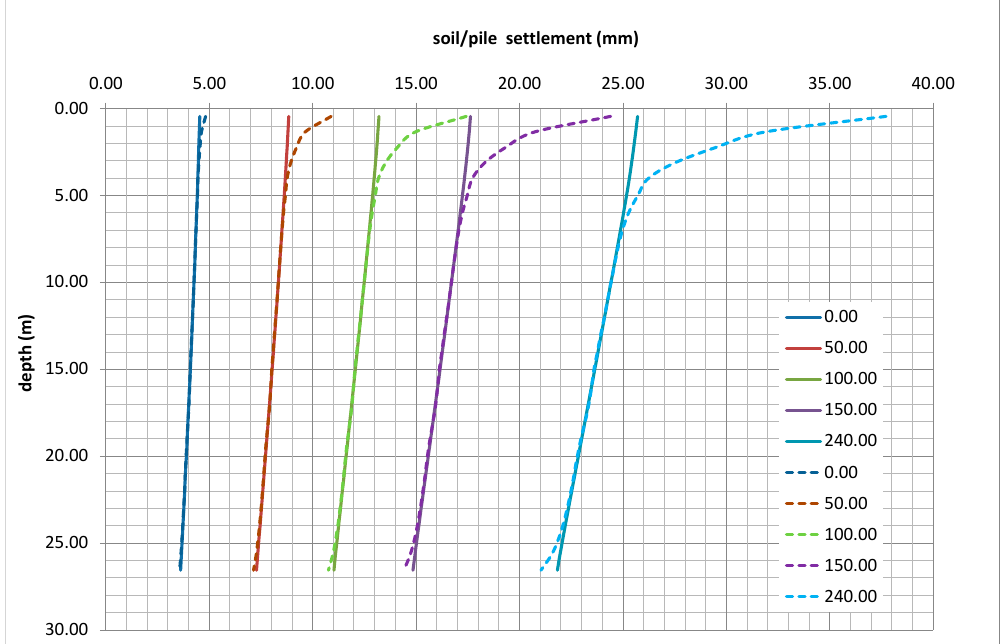
Figure 14. Model analytical outputs pile and soil settlements.